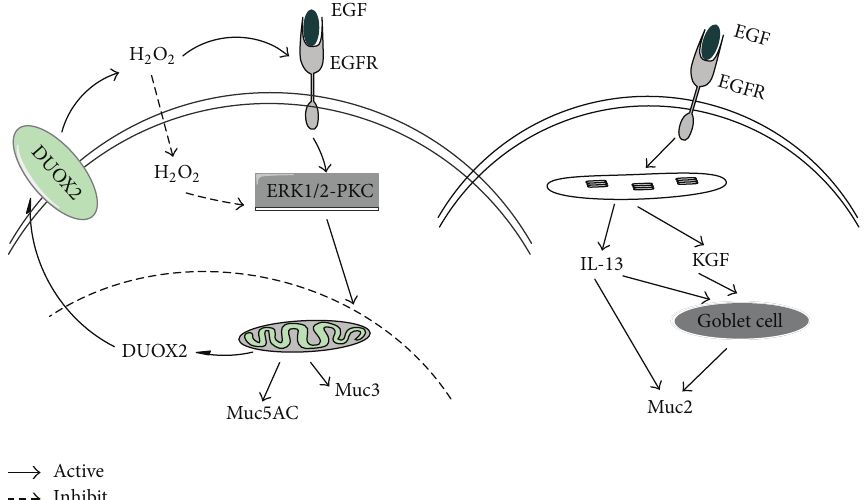
Table 3: Effects of EGF on intestinal bacterial colonization and translocation. Animals Significant results Reference EGF treatment significantly inhibits enteropathogenic Escherichia coli New Zealand white rabbits colonization in the small and large intestine Administration of EGF significantly reduced bacterial translocation Newborn rabbits and was associated with increased goblet cells in intestine Administration of EGF significantly reduced aerobic bacterial Rats colonization EGF reduced Campylobacter jejuni colonization in the jejunum and White leghorn chicks dissemination to the liver and spleen and inhibited Escherichia coli translocation An intervention with EGF decreased fecal Escherichia coli Rats colonization EGF treatment decreased the amount of Escherichia coli in the ileum Early-weaned piglets and cecum and Enterococcus counts in the